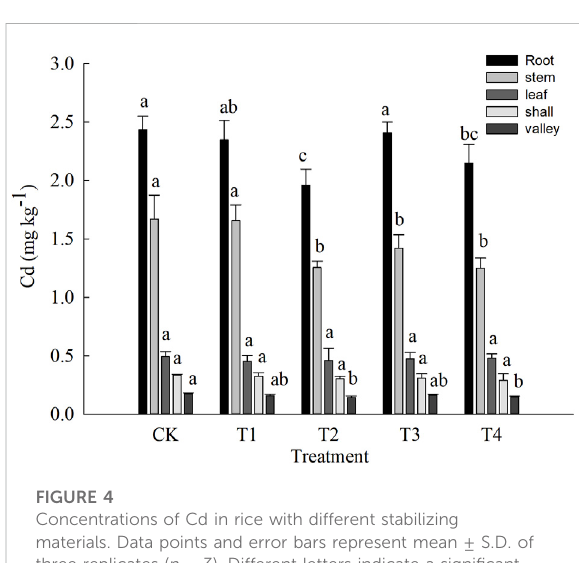
Concentrations of Cd in rice with different stabilizing materials. Data points and error bars represent mean ± S.D. of three replicates ( n = 3). Different letters indicate a signi fi cant difference between different treatments in the same period ( p <